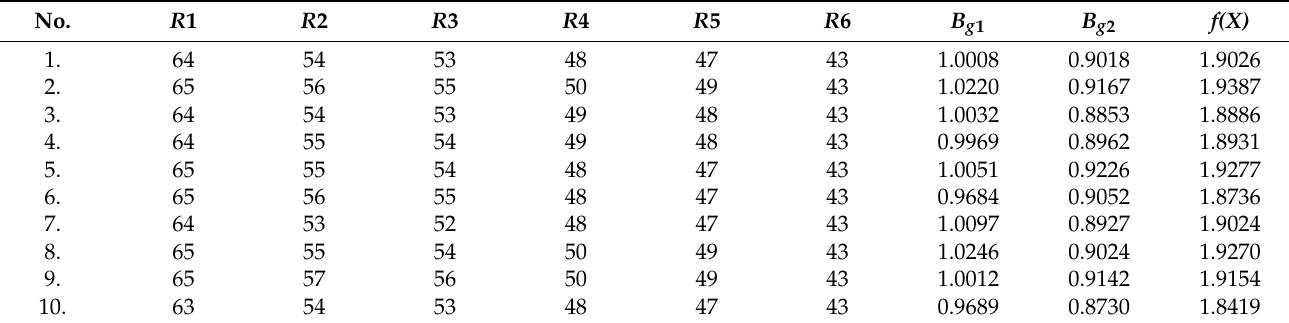
Table 7. The analytical calculation results.